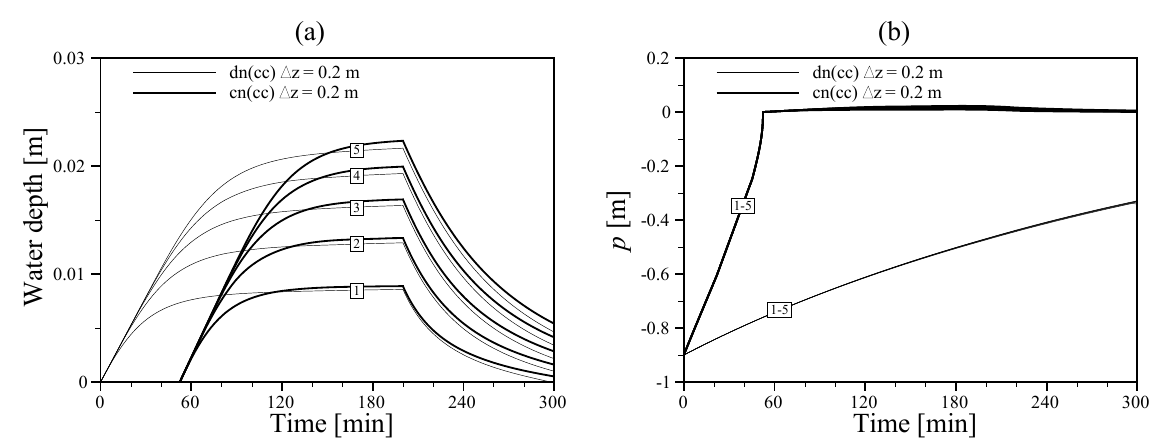
Figure 9. Simulated values for excess infiltration on a hillslope with a cell-centered scheme (second scenario) and (cid:49)z = 0.2m. (a) Water depths at the surface nodes. (b) Pressure heads at the topmost subsurface nodes. Nodes are numbered 1–5 in the downslope direction.